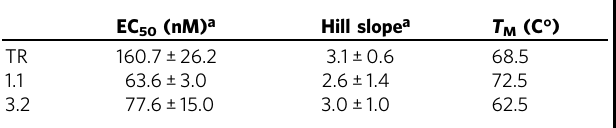
Trastuzumab is abbreviated as TR. Values were determined by pooling means from four ELISA experiments conducted with separate protein preps, each with four technical replicates per ELISA experiment, and calculating mean and s.d. of pooled means. Melting temperature data re fl ectsmeanoftwoexperimentsconductedwithseparateproteinpreps,eachconsistingoffour technical replicates. Source data are provided as a Source Data fi